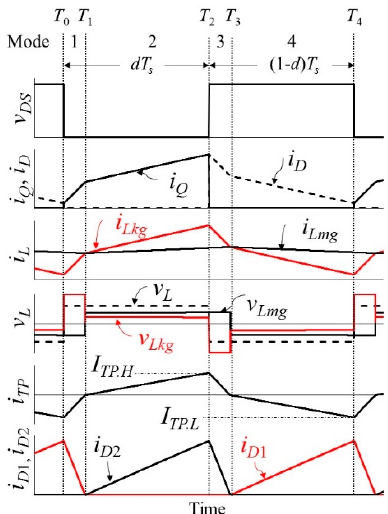
Figure 9. Key operation waveforms when PV 1 is partially shaded.